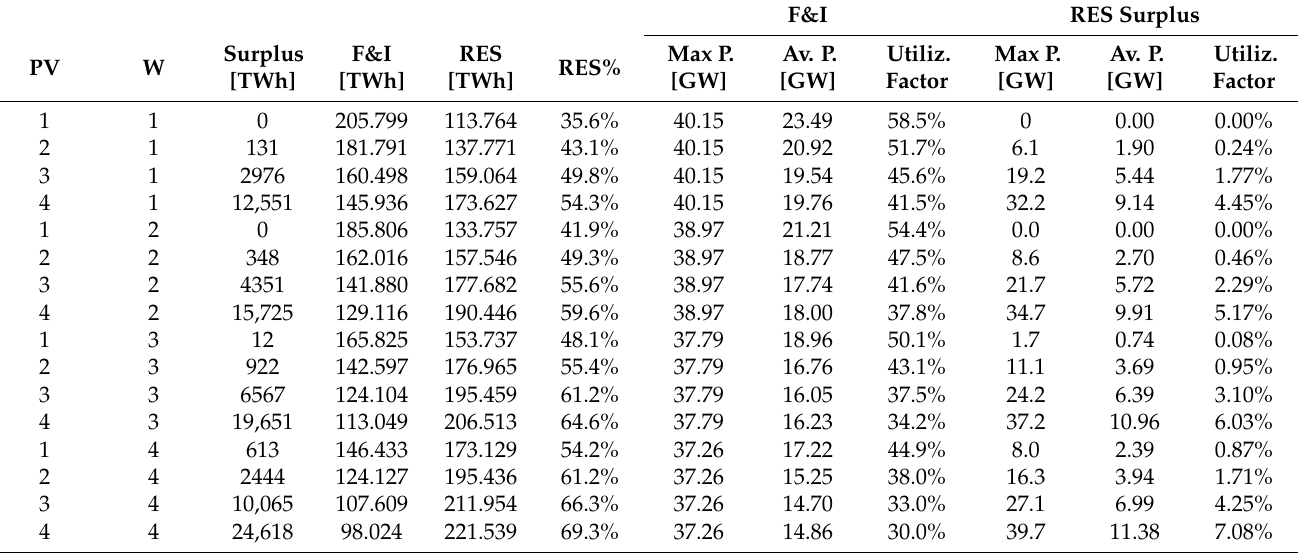
Table 2. Summary of the numerical results found in this